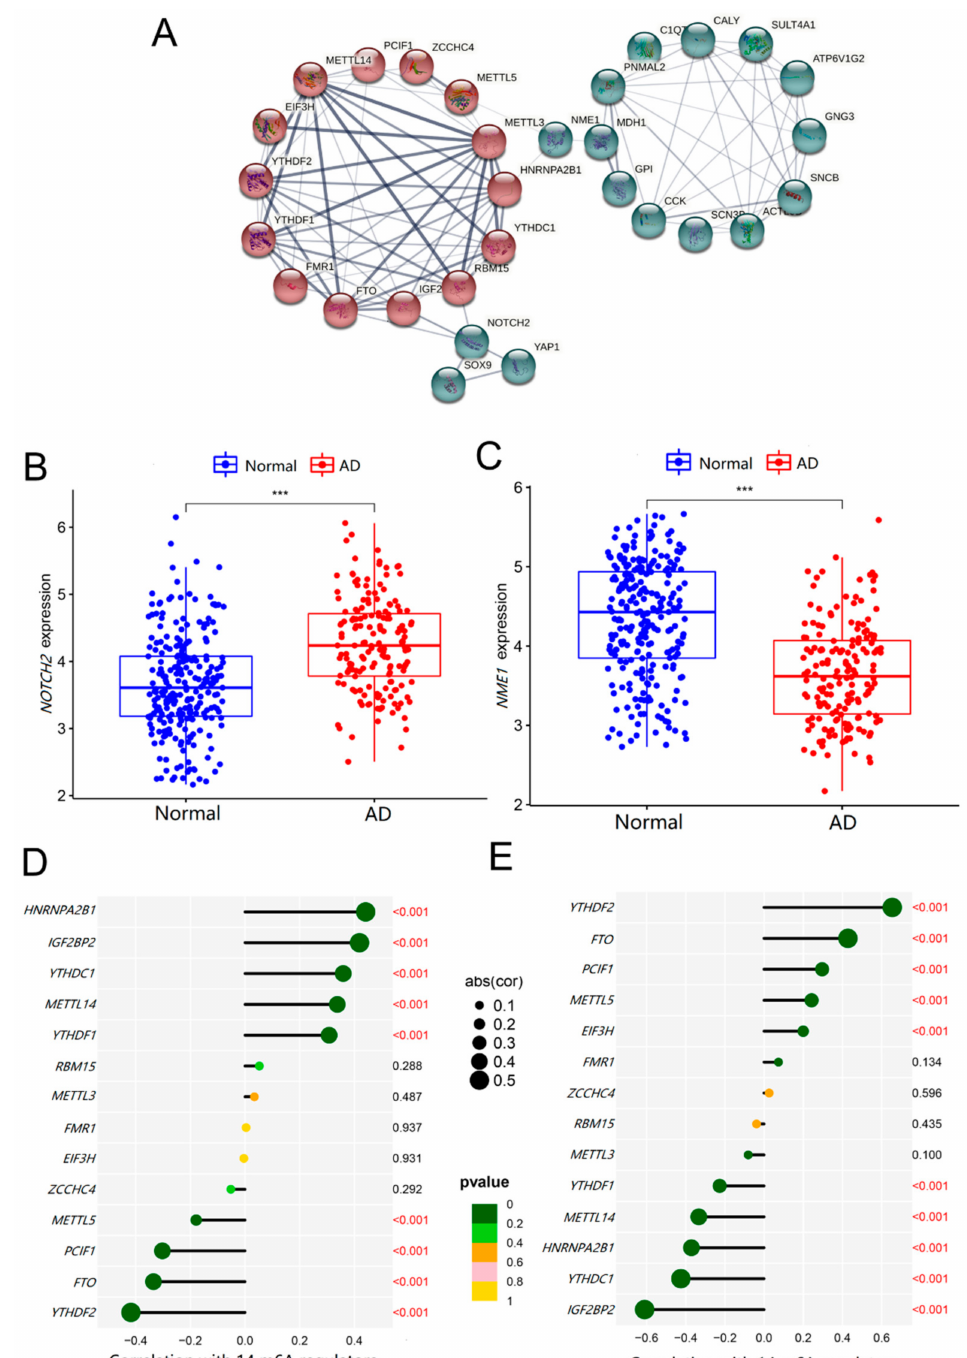
Figure 7. The relationships of m6A regulators and key AD genes. ( A ) PPI network was constructed by 14 m6A regulators as well as 19 key AD genes, with the disconnected proteins being hidden. Wider lines indicate stronger evidence of protein interactions. ( B , C ) The t -test was conducted to analyze the difference in the expression of NOTCH2 and NME1 between normal controls and AD patients. ( D , E ) The Pearson’s test was performed to analyze the correlation between NOTCH2 and NME1 and m6A regulators. The results with significant differences was marked as *** p <